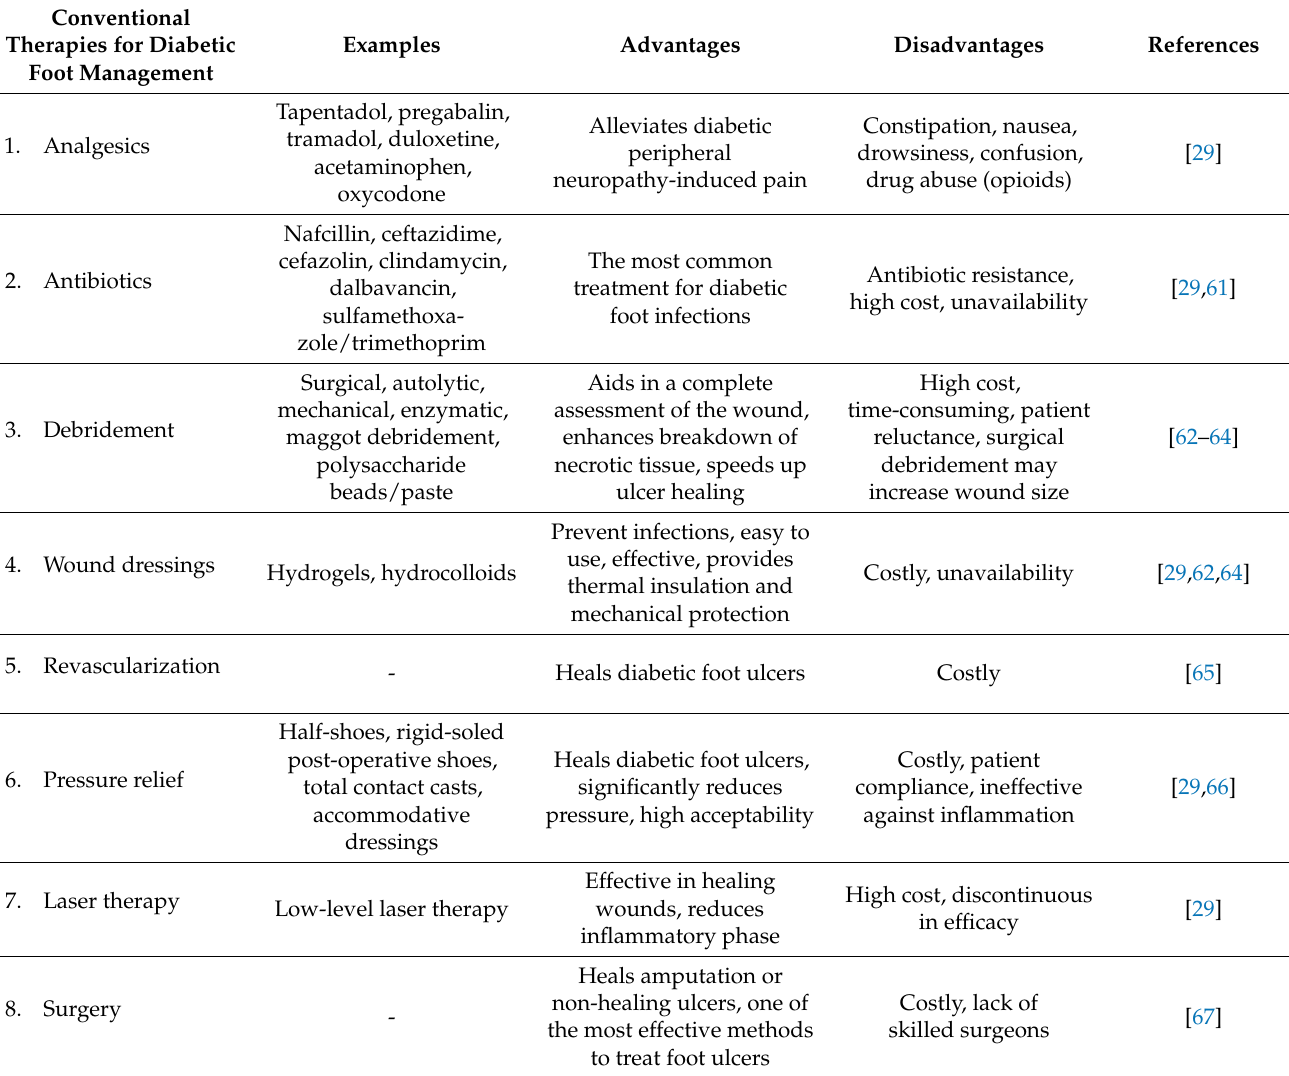
Table 1. Current therapeutic strategies for the treatment of diabetic